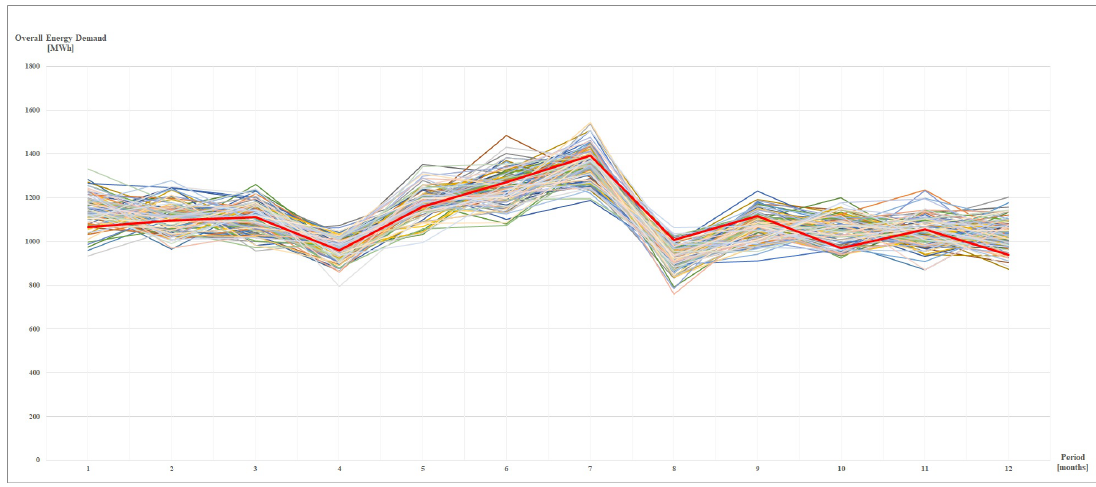
Figure 3. Scenarios for the overall energy